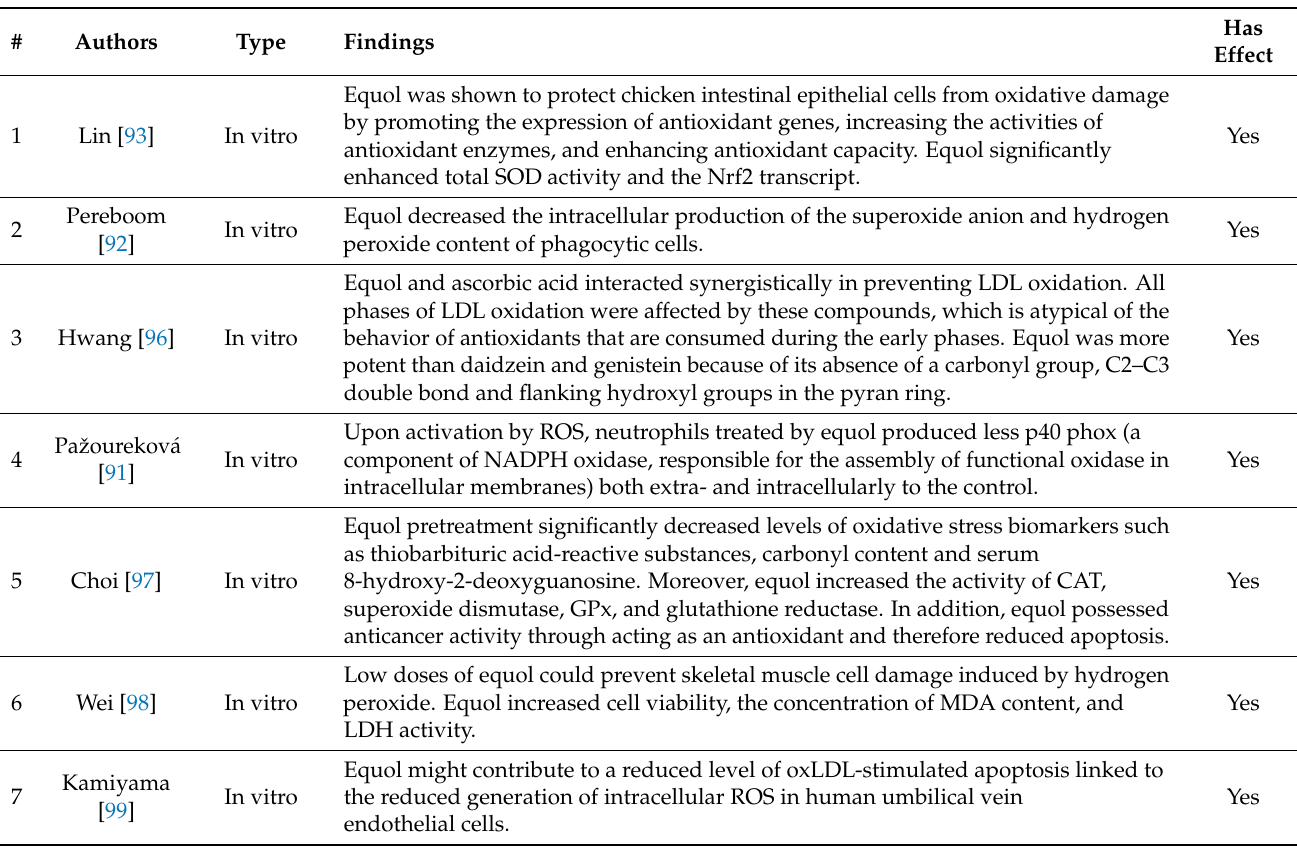
Figure 4. Signaling and pathways on which equol exerts antioxidative effect. ( A ): ROS pathway [99] . ( B ): NADPH pathway [91]. “ ⊥ ” indicates the inhibitory effect by equol. MDA: malondialdehyde, 4-HNE: dyhidroxynonel, LOOHs: lipid hydroperoxides, ROS: reactive oxygen, DNA: deoxyribonucleic acid, ONOO-: peroxynitrite, NO 2 : nitrogen dioxide, O 2 -: superoxide, MPO: myeloperoxidase, NADPH: nicotinamide adenine dinucleotide phosphate, apoB: apolipoprotein B, iNOS: inducible nitric oxide synthase, H 2 O 2 : hydrogen peroxide. Table 2. Antioxidative effects of